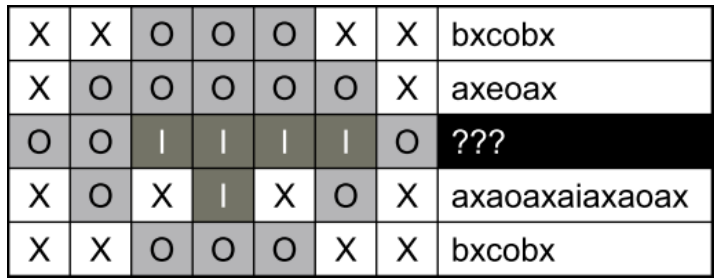
Fig. 3. Example for a task from the “Informatik Biber” [8, pp. 7, year 2010]